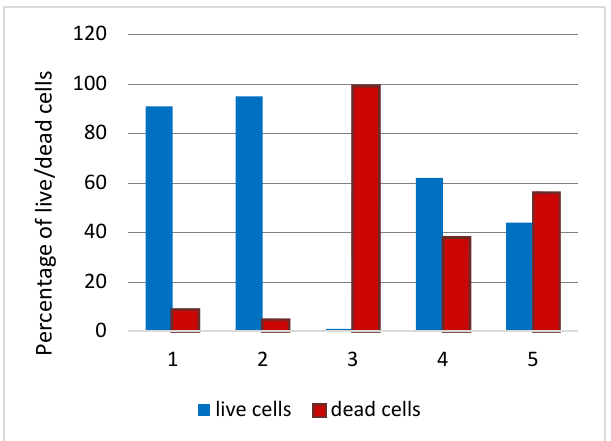
Figure 9. Percentage of live/dead cells after 24-h culturing with MCF-7 cells of TiNi samples treated with BU[6] by different methods: 1 — control sample, 2 — vacuum modification method, 3 — without external effects, 4 — microwave modification method, 5 — ultrasonic modification method.